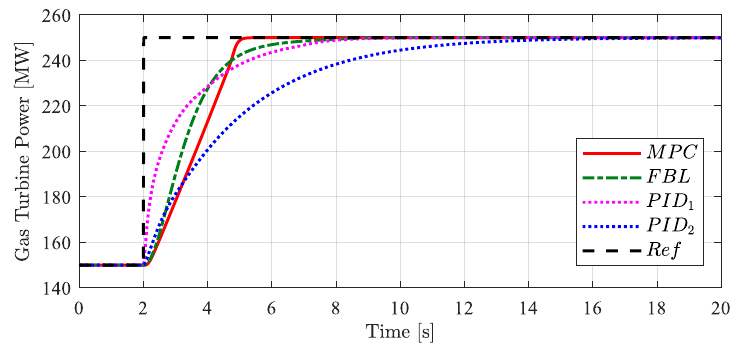
Figure 4. Power production time profile.